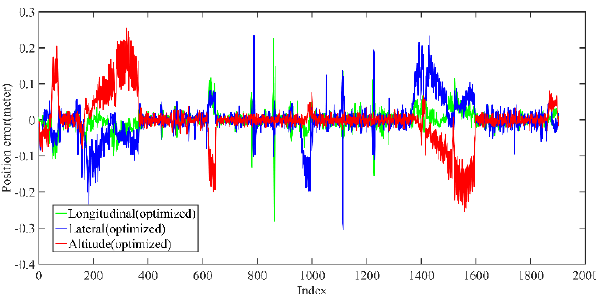
Figure 6. The optimized position error in longitudinal, lateral, and altitude directions of KITTI dataset, respectively; the error is significantly reduced after optimization.